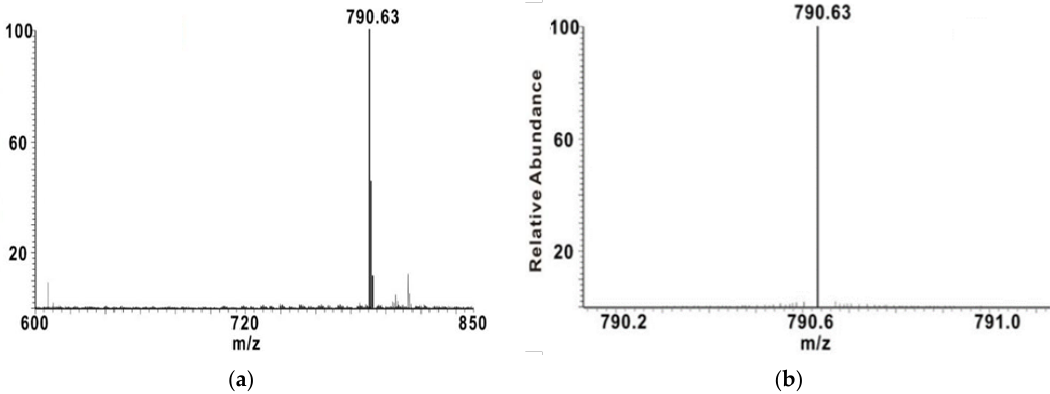
Figure 3. ESI mass spectra of DSPC: ( a ) detection in full-scan mode; ( b ) detection in selected ion- scan mode.